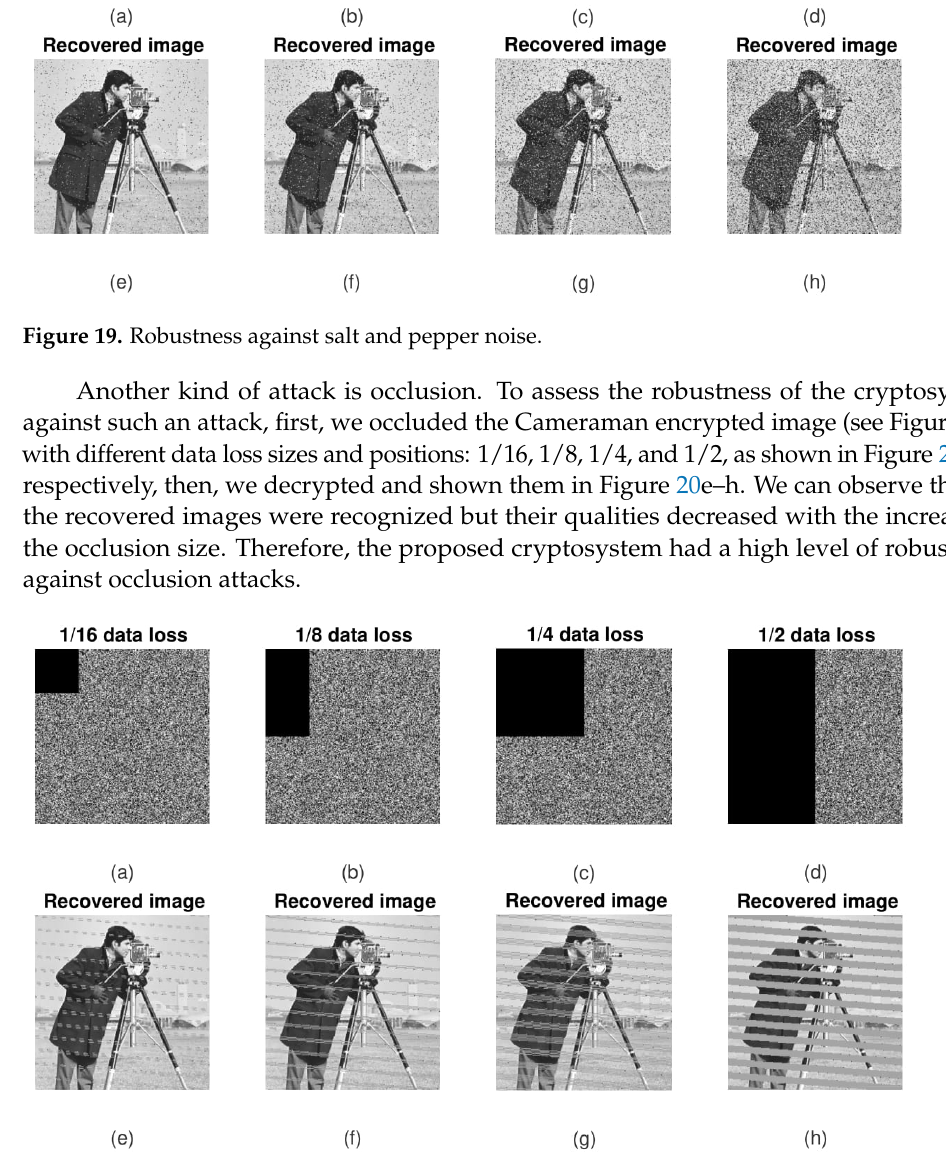
Figure 20. Robustness against occlusion